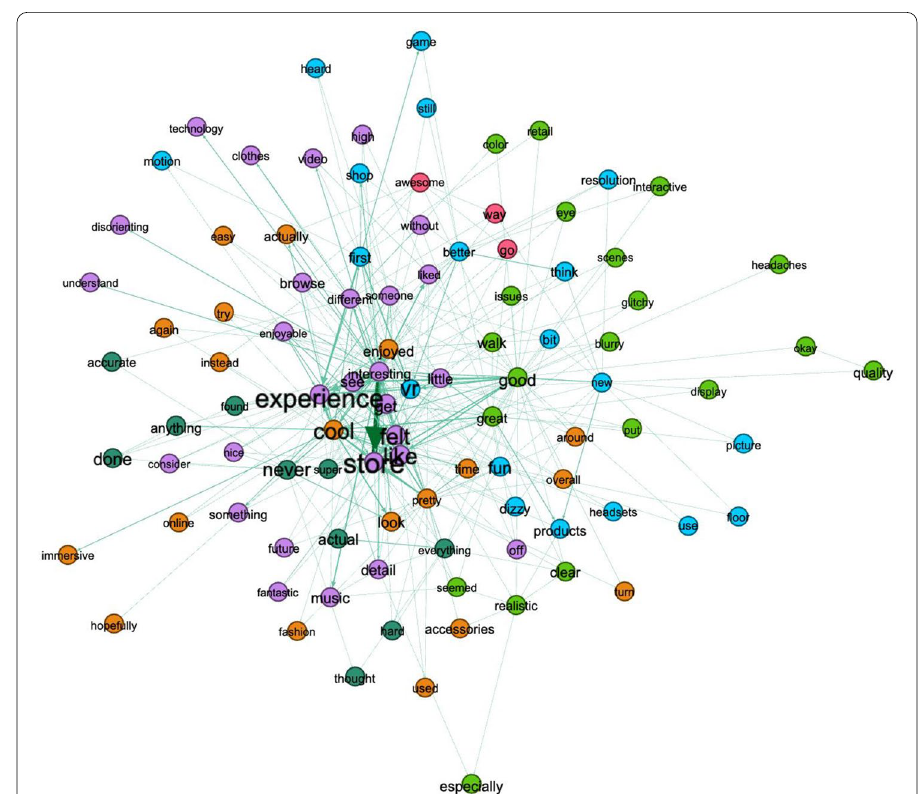
Fig. 4 Semantic network analysis result using